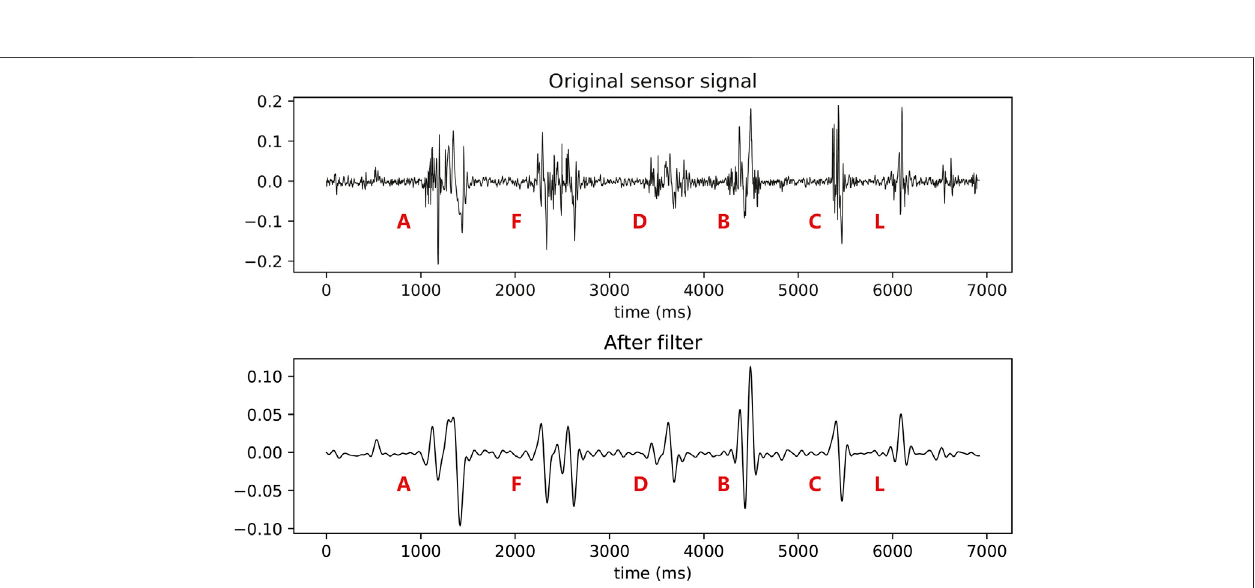
FIGURE 3 | Original vs. wavelet denoised sensor signals of handwriting